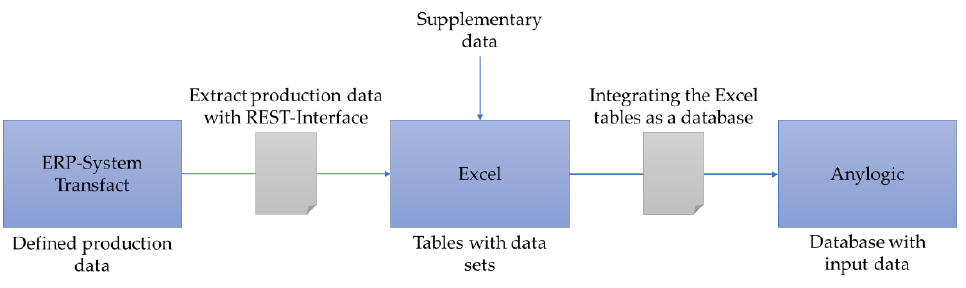
Figure 2. Data transfer from the enterprise resource planning (ERP) system Transfact TM to AnyLogic TM . AnyLogic TM